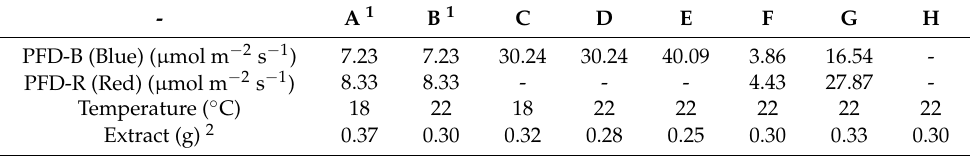
Table 1. Cultivation conditions and amount of extract obtained from raspberry